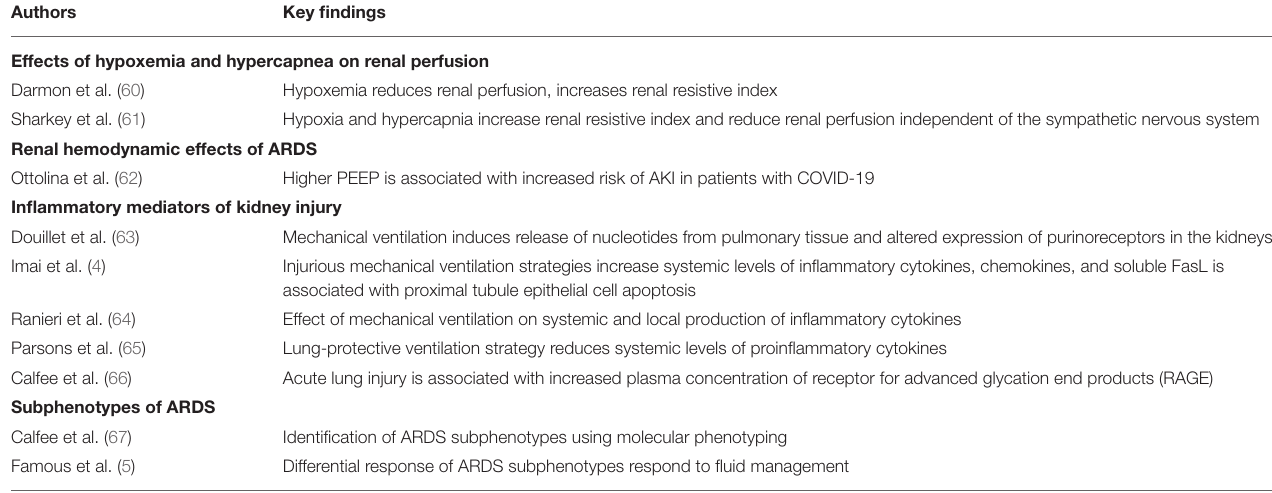
TABLE 2 | Selected publications highlighting lung mediated renal injury. Authors Key